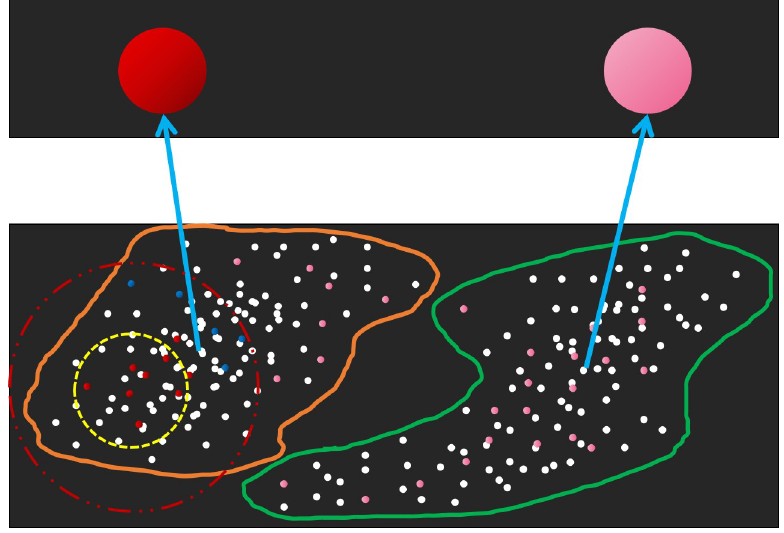
Figure 4. ( a ) shows the cognitive range of the activated IPN: the yellow dotted line is the excitatory interaction range and the red dotted line is the inhibition interaction range. ( b ) describes the activated and inhibited EPNs and ESNs in the cognitive